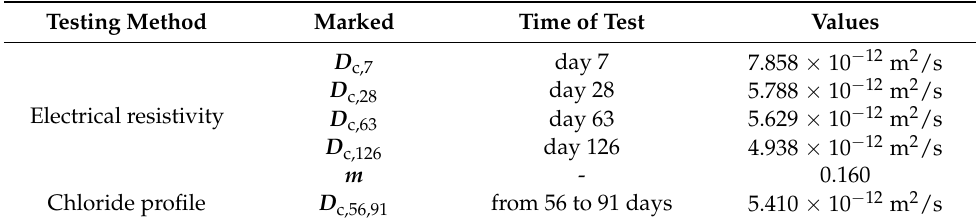
Table 2. Diffusion coefficients and corresponding test